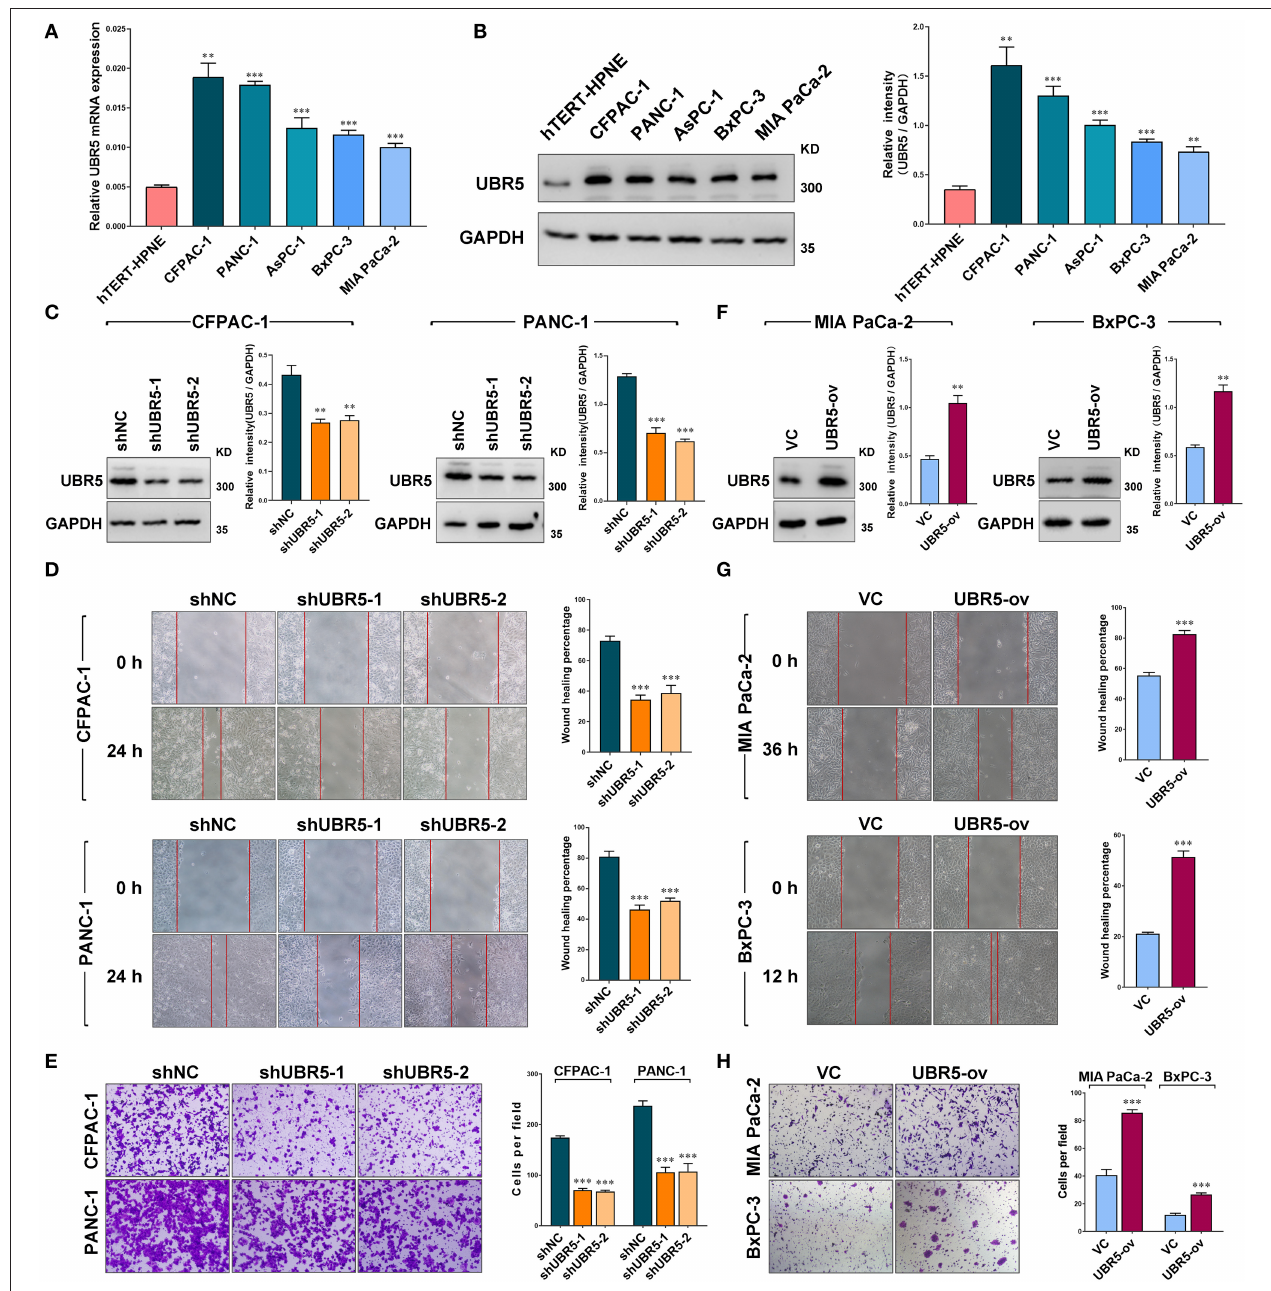
FIGURE 2 | UBR5 promotes pancreatic cancer migration and invasion in vitro . (A) Relative mRNA expression and (B) protein levels of UBR5 in various pancreatic cancer cells and normal pancreatic cells measured by quantitative real-time PCR and western blot separately. The histogram shows the densitometric analysis of the bands. (C) The protein levels of UBR5 in CFPAC-1 and PANC-1 cells after infection with shNC or shUBR5. The histogram shows the densitometric analysis of the bands. (D,E) Wound healing and invasion assays in CFPAC-1 and PANC-1 cells infected with shNC or shUBR5. (F) The UBR5 protein levels in MIA PaCa-2 and BxPC-3 transiently overexpressing UBR5. The histogram shows the densitometric analysis of the bands. (G,H ) Wound healing and invasion assays in MIA PaCa-2 and BxPC-3 transiently overexpressing UBR5. Data represents mean ± SEM (n = 3 independent biological repeats). **, P < 0.01; ***, P <